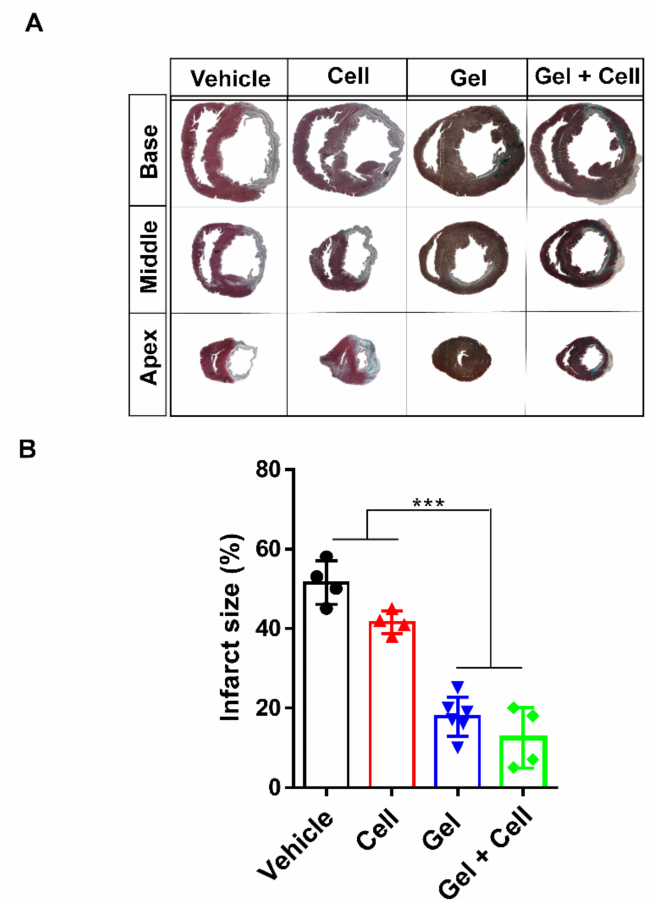
Figure 4. (RADA) 4 -SDKP hydrogel diminished scar size. ( A ) Representative images of Masson’s trichrome (MT) stained heart sections at the apex, middle, and base areas for all groups. ( B ) At day 28, the infarct area (% of left ventricle (LV)) was decreased in the Gel and Gel + Cell groups in comparison with the Cell and Vehicle groups. All data are presented as mean ± standard deviation ( n ≥ 4).*** p <